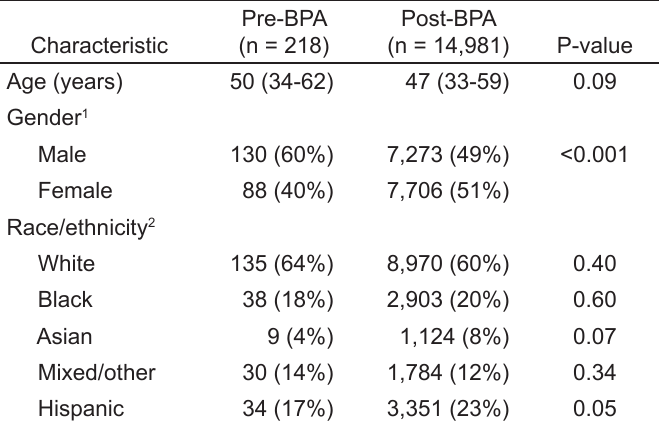
Table 1. Patient characteristics by study period.